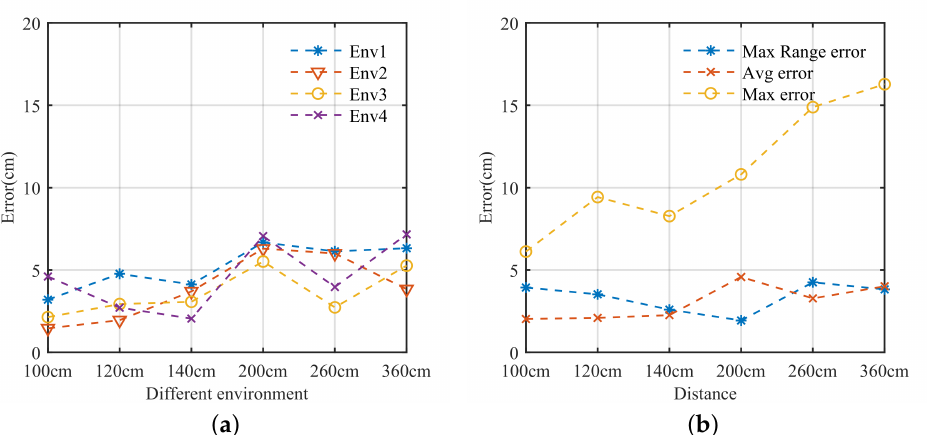
Figure 14. MAL positioning error in different environments. ( a ) Errors in four different environments. ( b ) Maximum error, average error, and difference between maximum and minimum error over the same